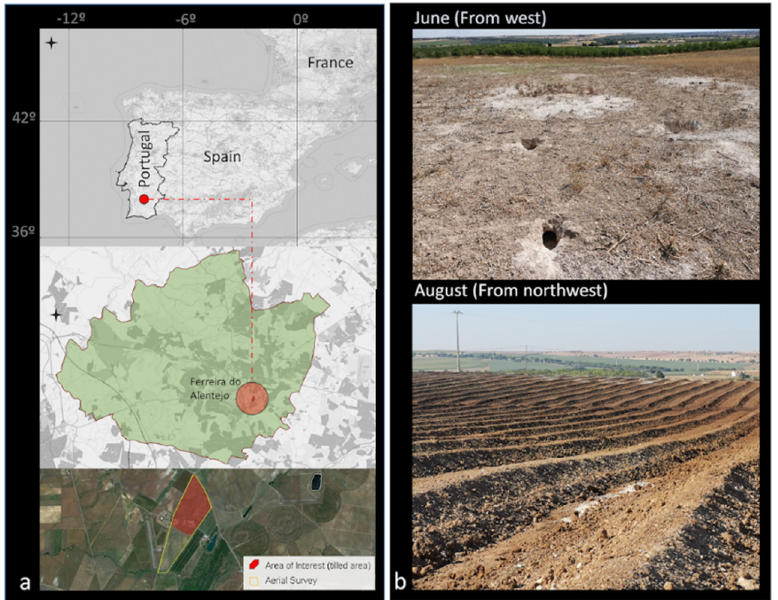
Figure 2. Location of the study area in Portugal, Alentejo: aerial survey and area of interest ( a ); onsite images captured in June and August ( b ).